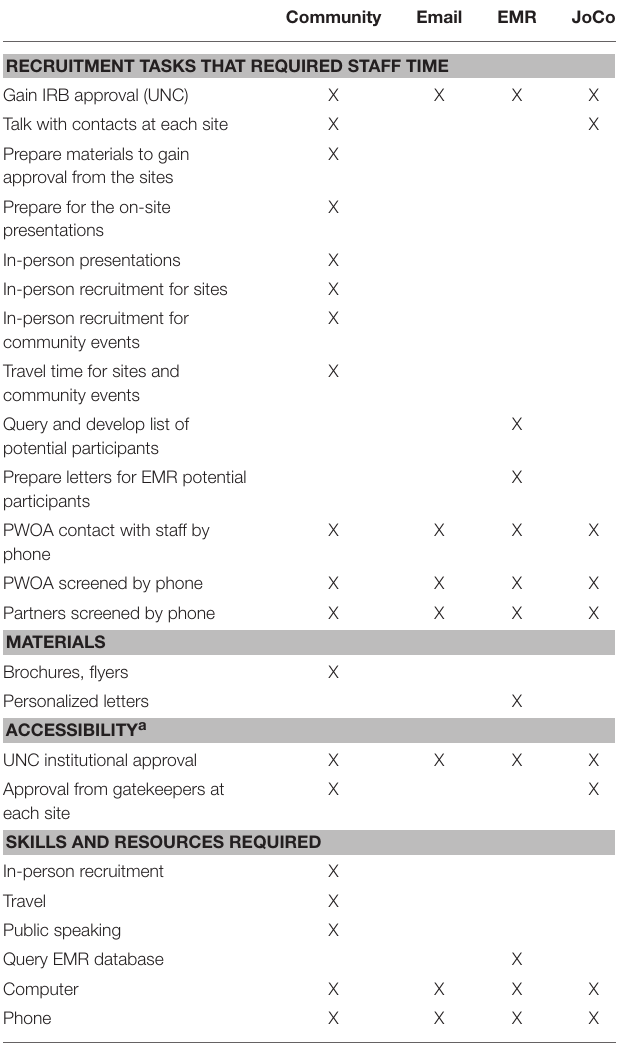
TABLE 3 | Summary of resources for recruitment methods employed in PALS.